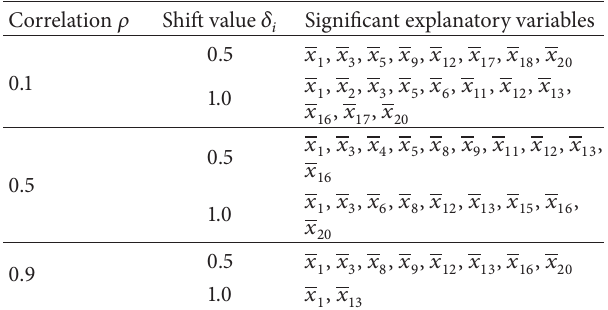
Table 2: Significant variables selected by LR